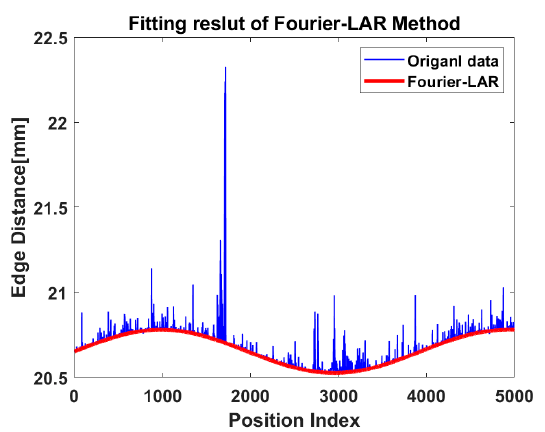
Figure 12. The Fourier fi tt ing result with LAR method of actual edge distance.